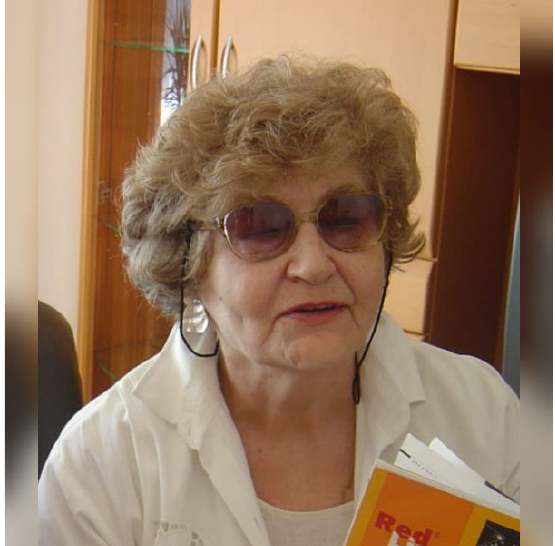
Figure 1. Natalya Nikolaevna Vygodskaya.